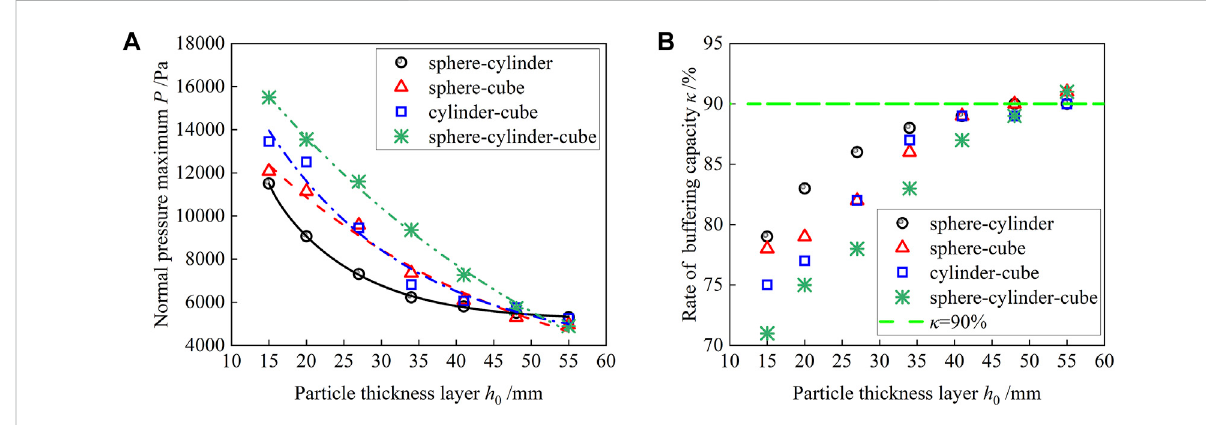
FIGURE 10 In fl uence on particle thickness layer for impact pressure of bottom plate: (A) normal pressure maximum P ; (B) rate of buffering capacity κ .